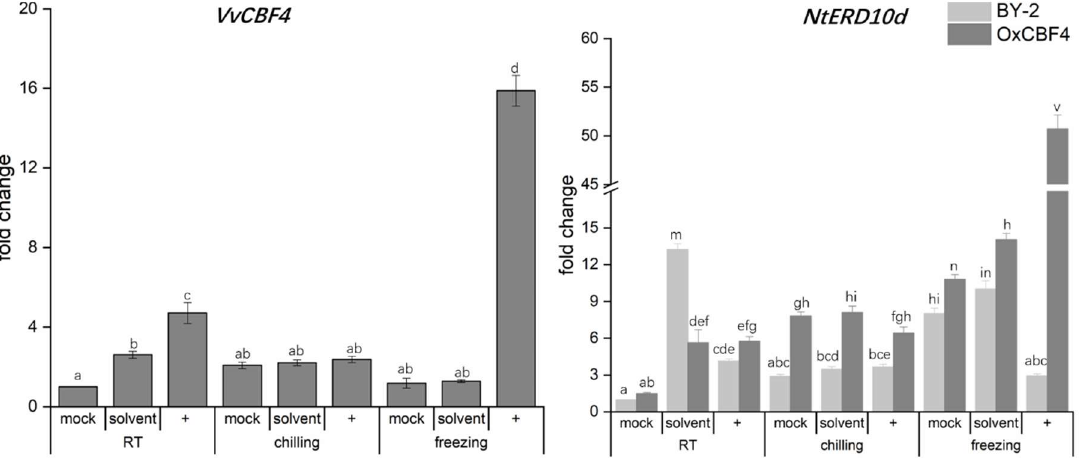
Figure 8. Effect of the lipoxygenase inhibitor phenidone on the expression of VvCBF4 (in the VvCBF4ox line) and the COR transcript NtERD10d (in both non-transformed tobacco BY-2 and the VvCBF4ox line) under 25 °C (room temperature, RT), chilling (4 °C), or freezing (0 °C) stress, represented by fold change (2 −ΔΔCt method). Expression was scored 24 h after the onset of the stress treatment either without phenidone (mock) or after pre-treatment for 30 min with 2 mM phenidone (represented by +) or the same volume of ethanol as the solvent control. Data are normalised to the expression levels under room temperature without any of the inhibitors and represent means ± SE of the three independent experiments in technical triplicate. Statistically significant differences are represented as different letters in the LSD test ( p < 0.01). NtERD10d is based on its mRNA level in non-transformed BY-2 cells.